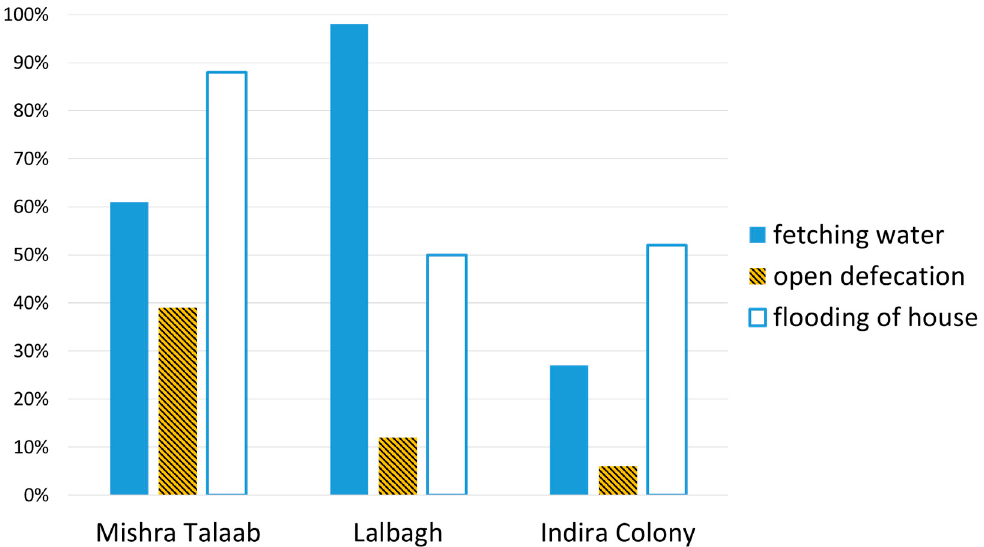
Figure 2. Responses of households (HHs) about their most evident sanitation problems: During the past year, did they occasionally (or more often) fetch water, practice open defecation or experience flooding of their houses? Plot and computations using MS Excel.